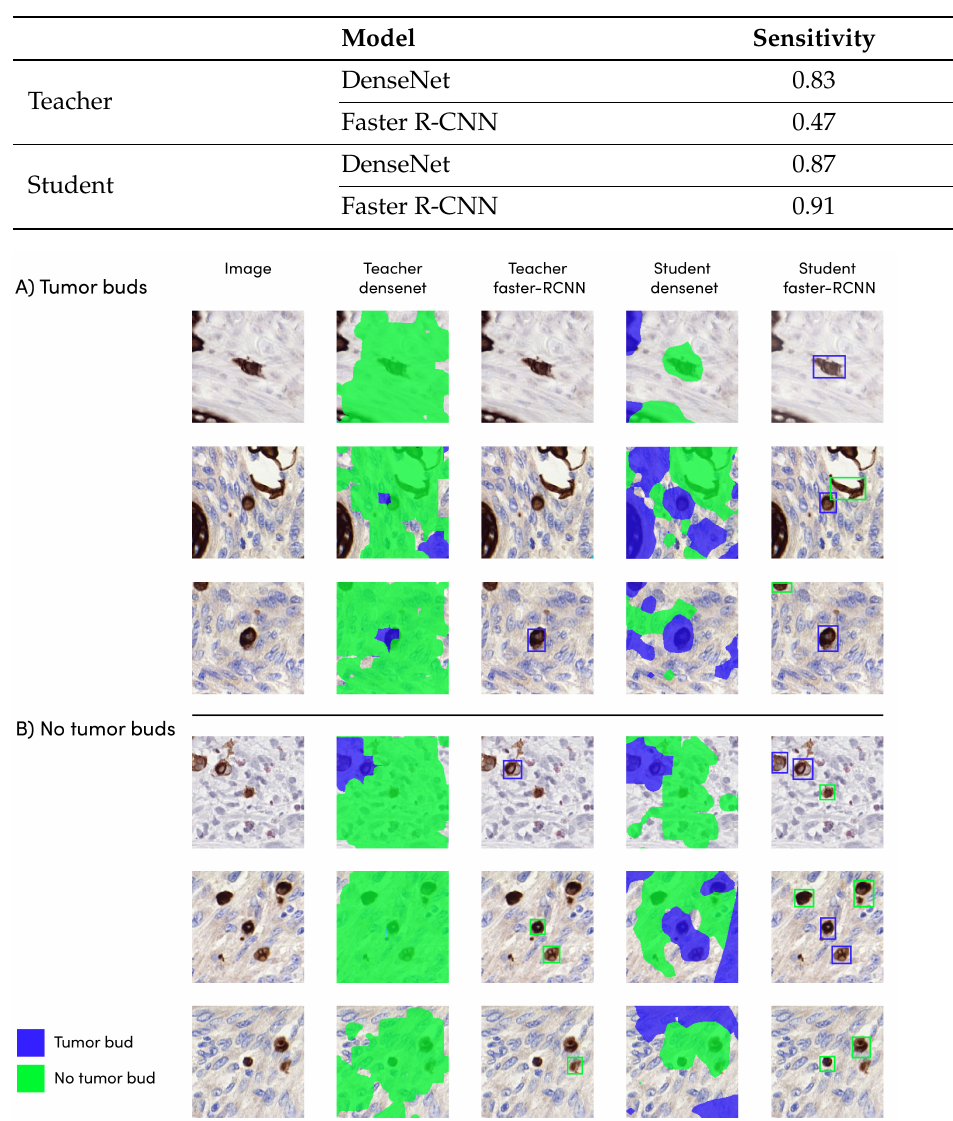
Table 3. Sensitivity scores of different teacher and student models on dataset dev-t. The overall best performing model was highlighted.